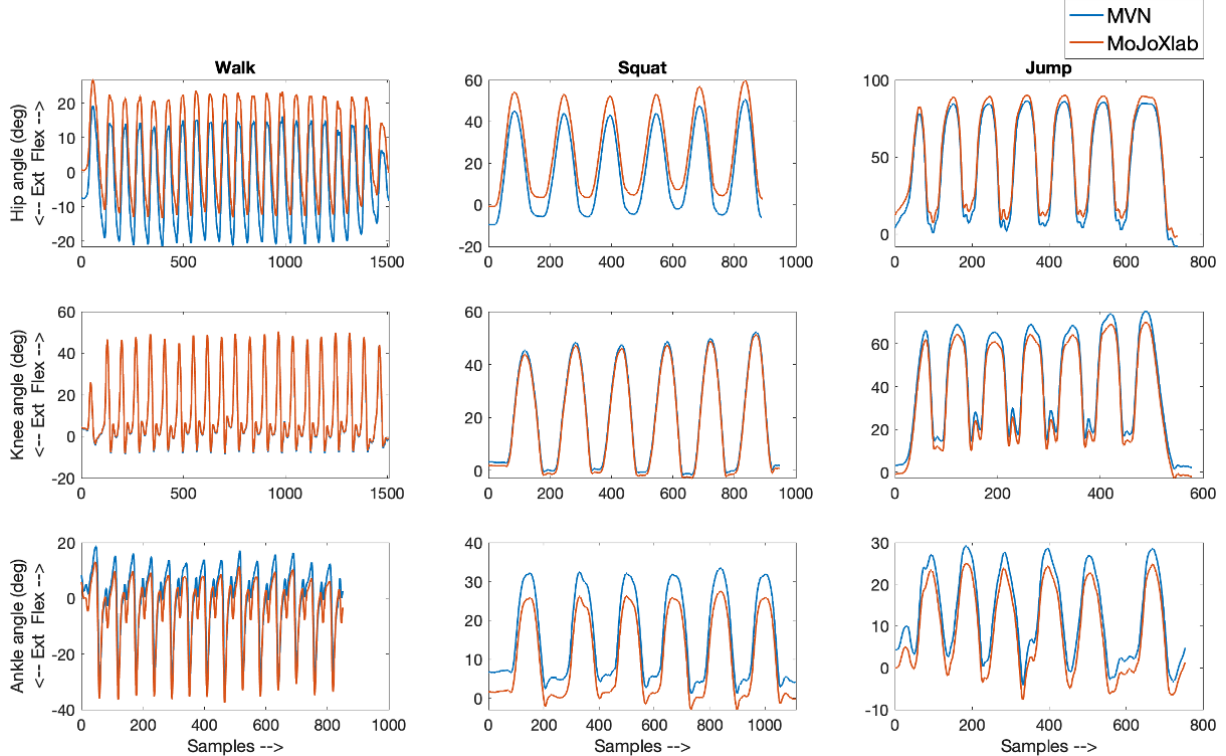
Figure 5. Representative sagittal plane joint angle waveforms selected from the anterior cruciate ligament reconstruction participant data set. Waveforms for the hip (top row), knee (middle row), and ankle (bottom row) joint angles obtained from MVN Analyze (blue) and our custom software MoJoXlab (orange) for walking (left), squatting (center), and jumping (right) tasks. The y-axis represents joint angles in degrees, and the x-axis represents data samples across the entire waveform.